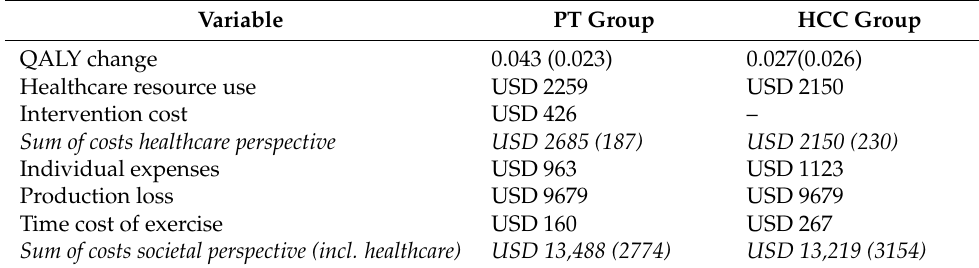
Table 3. Average effects and costs (standard errors) in the PT and HCC groups. Variable PT